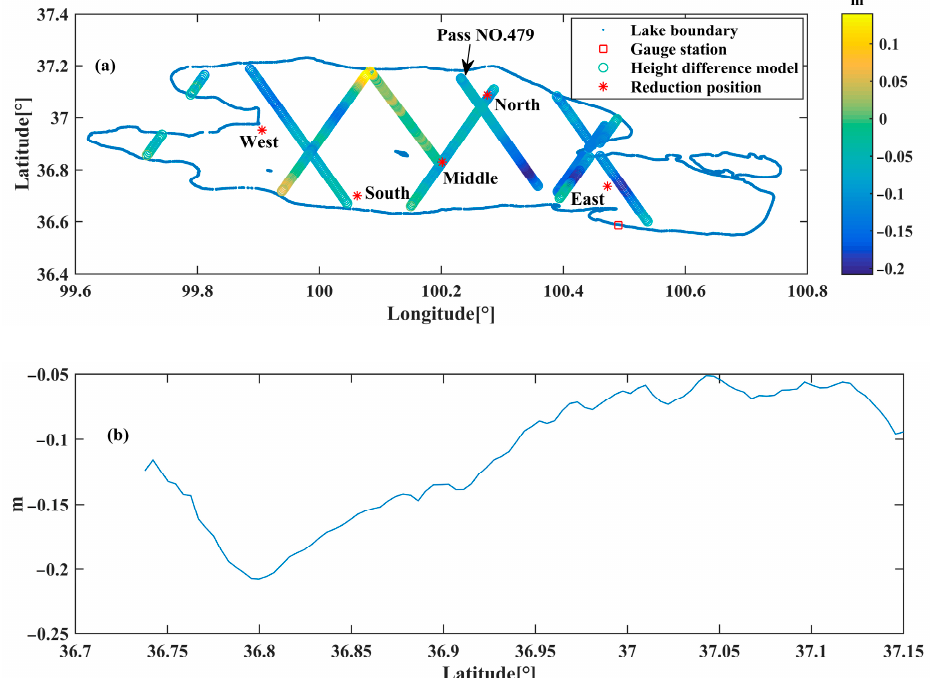
Figure 7. ( a ) Lake height di ff erence model constructed using data from ERM missions; ( b ) lake height di ff erence in Pass No. 479 area.